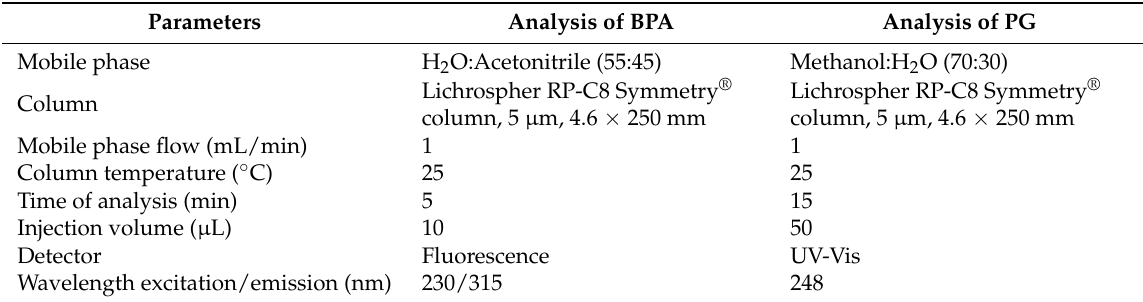
Table 2. Chromatographic conditions for the analysis of bisphenol A and progesterone. Parameters Analysis of BPA Analysis of PG Mobile phase H 2 O:Acetonitrile (55:45) Methanol:H 2 O (70:30) Lichrospher RP-C8 Symmetry ® Lichrospher RP-C8 Symmetry